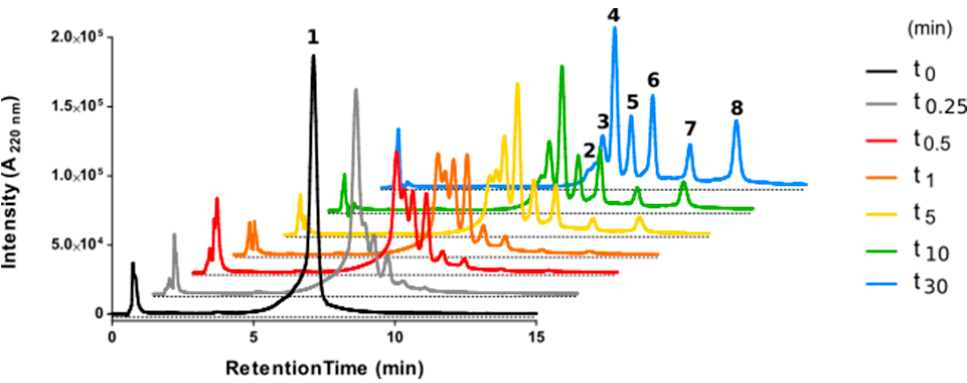
Figure 3. High-performance liquid chromatography (HPLC) analysis of fully linear peptide 1 on incubation with trypsin over 30 min. Starting material corresponds to peak 1 (black trace). Main tryptic fragments ( 2 − 8 ) are identified by mass on Table 2.